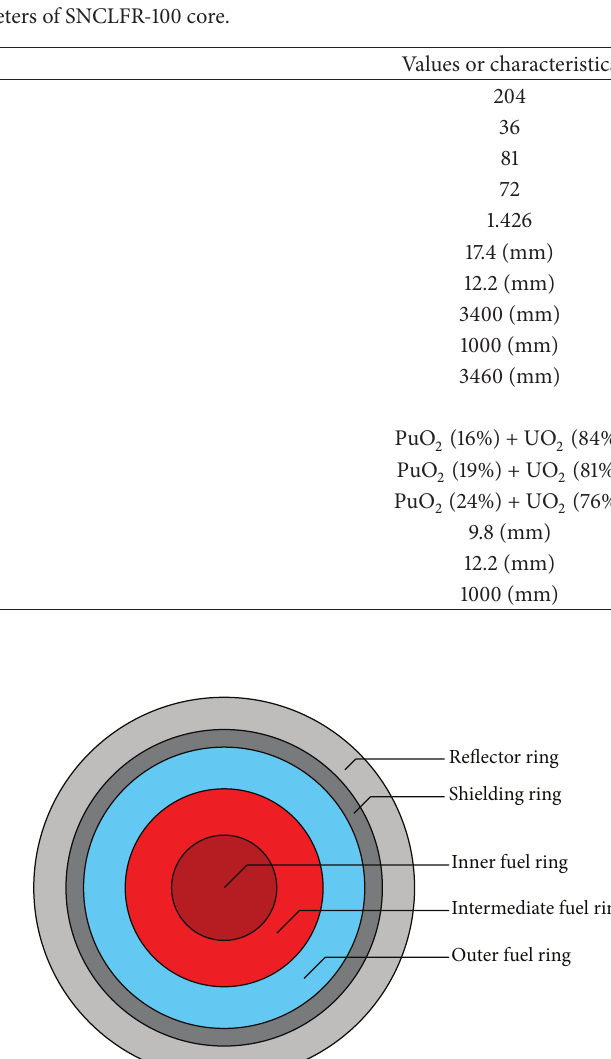
Table 2: Design parameters of SNCLFR-100 core.